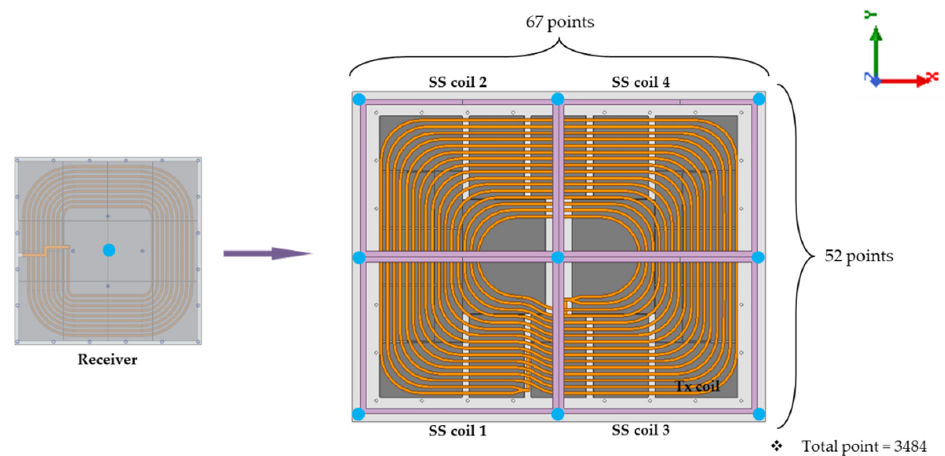
Figure 8. Simulation method of the position-detection performance.